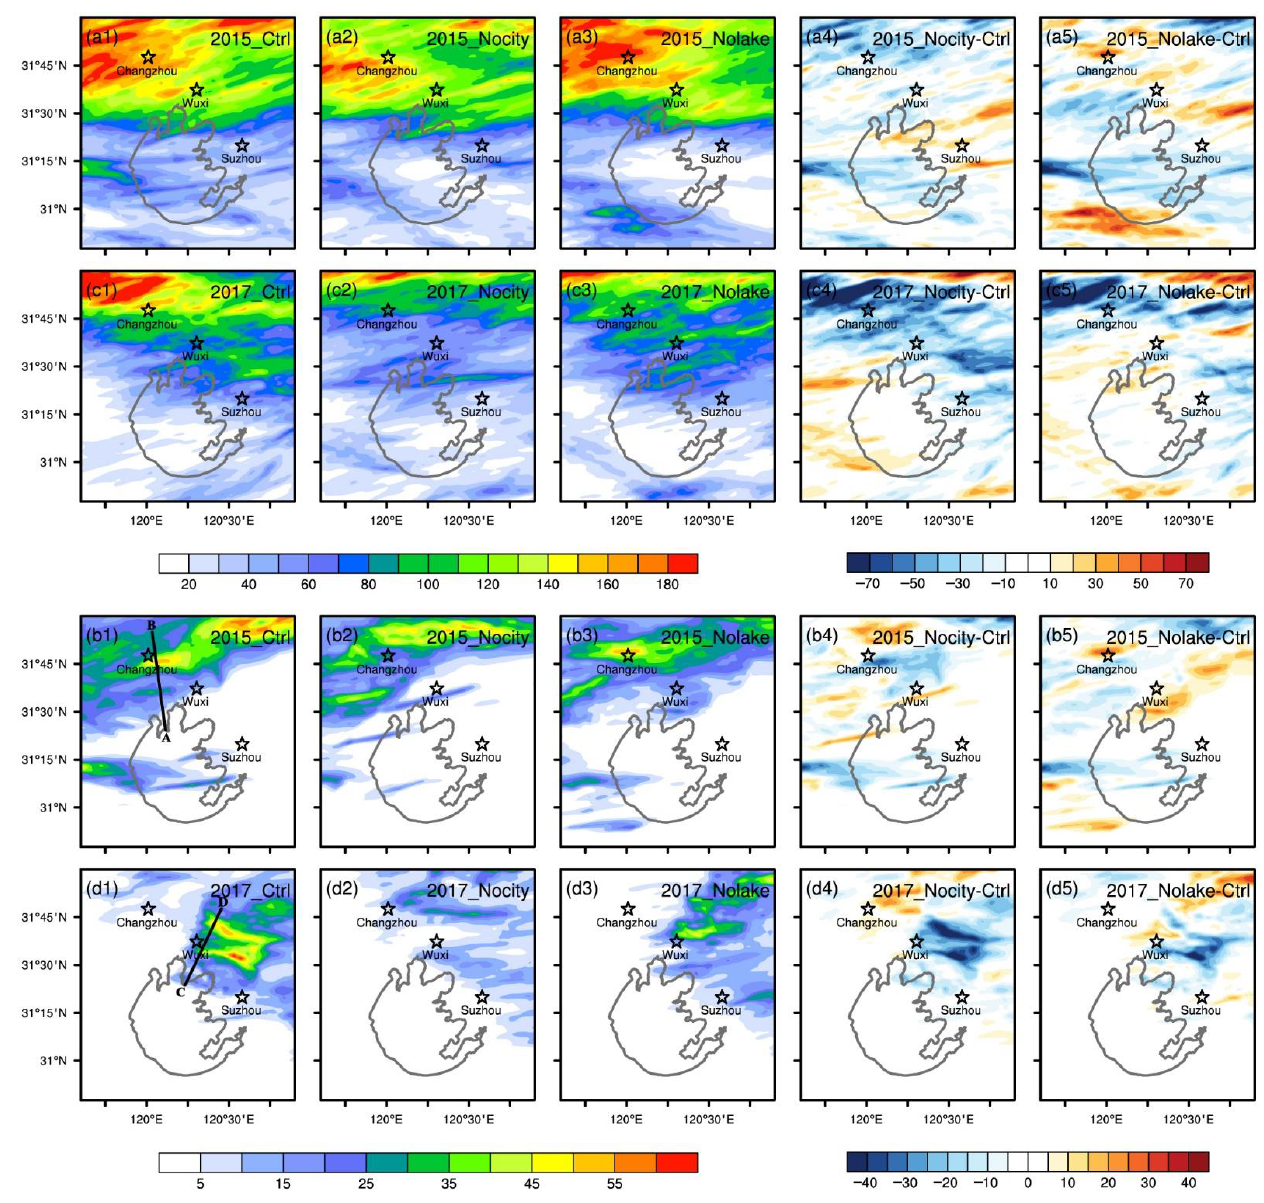
Figure 6. The distributions of the simulated daily precipitation (unit: mm) in the ( a1 ) control and ( a2 , a3 ) two sensitive (Nocity and Nolake) runs for EP627, as well as ( a4 , a5 ) the differences between the sensitive runs and the control run. ( c1 – c5 ) are the same as ( a1 – a5 ), but for EP925. ( b1 – b5 ) and ( d1 – d5 ) are the same as ( a1 – a5 ), but for the maximum hourly precipitation which occurred from 15:00–16:00 for EP627 and from 13:00–14:00 for EP925. The line AB in ( b1 ) and the line CD in ( d1 ) are the cross sections used in the latter